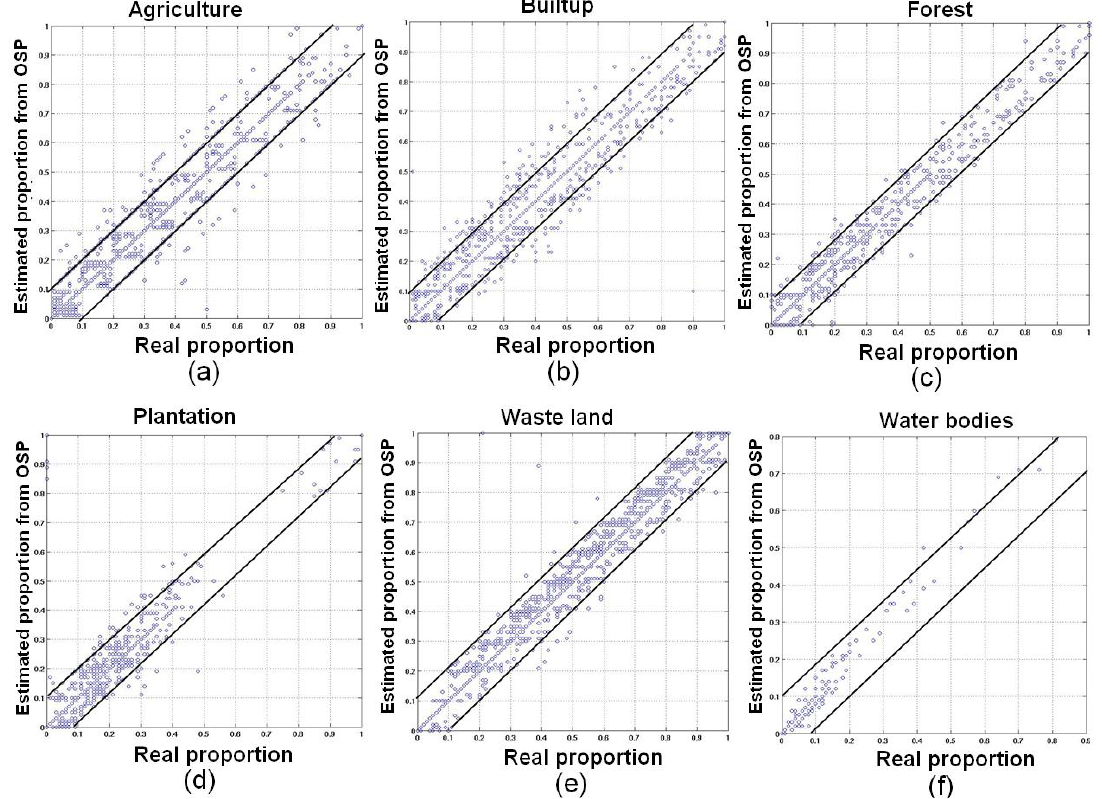
Figure 12. BDFs of MODIS test data from LMM. ( a ) agriculture; ( b ) built-up/settlement; ( c ) forest; ( d ) plantation/orchard; ( e ) wasteland; ( f ) water